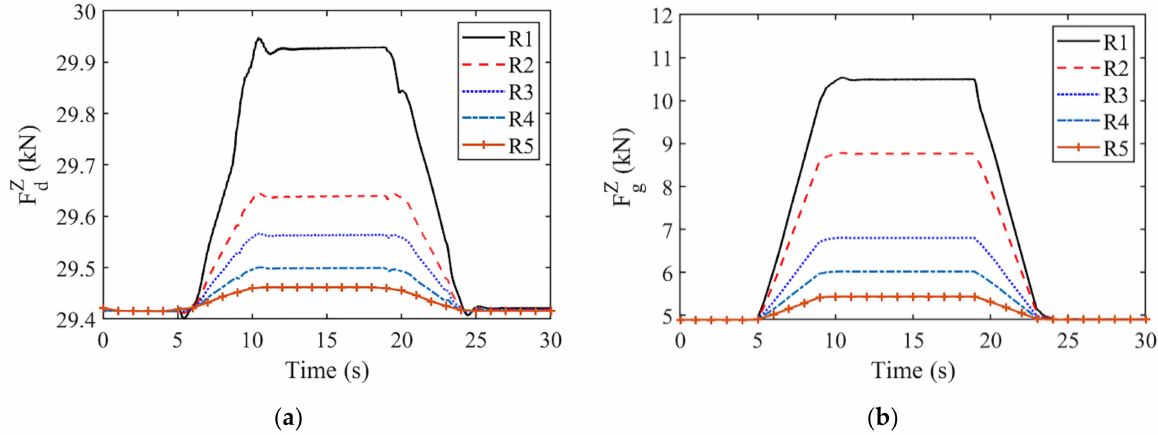
Figure 9. Record of vertical force of driving wheels: ( a ) Record of vertical force of driving wheels; ( b ) Record of vertical force of guiding wheels.